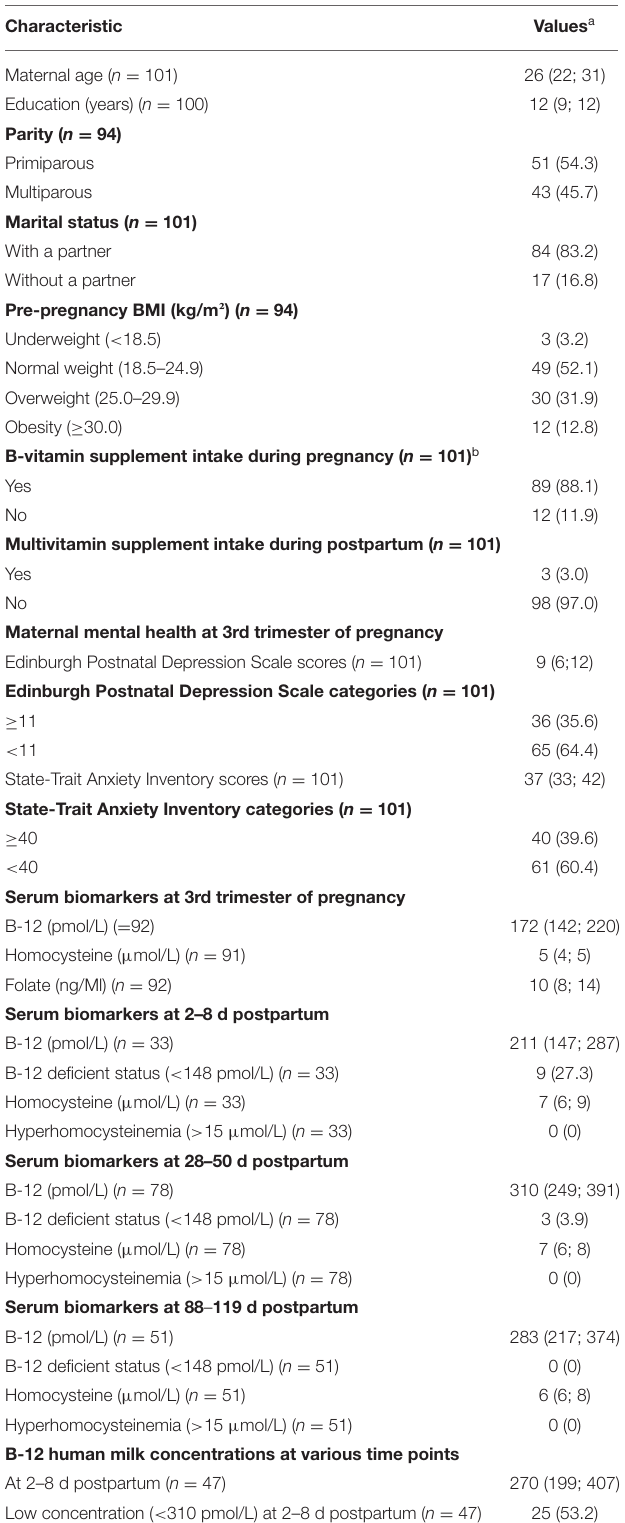
TABLE 1 | Characteristics, biomarkers, and human milk concentrations of participants followed in the cohort in Rio de Janeiro, Brazil.